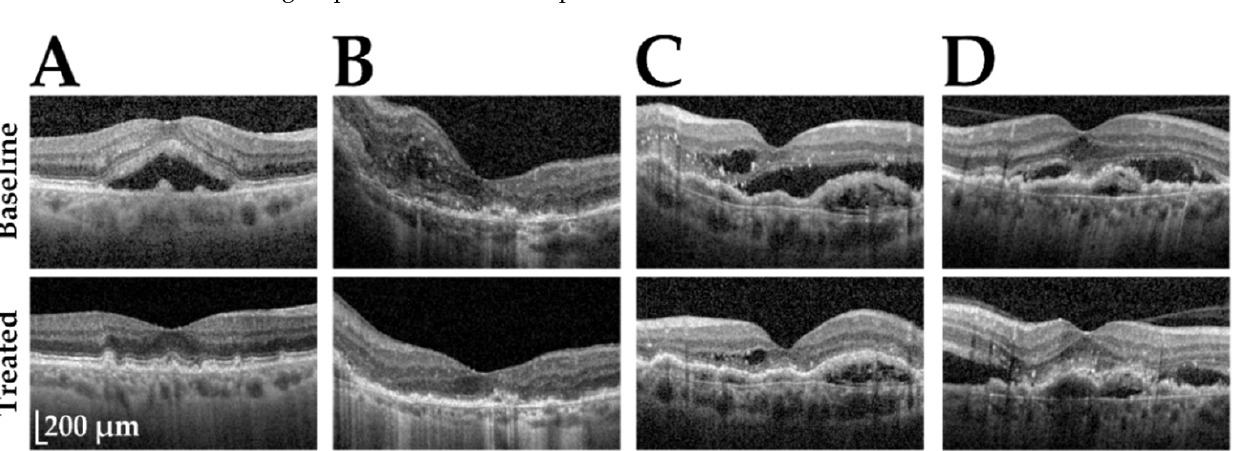
Figure 1. Exemplary optical coherence tomography (OCT) images of nAMD patients and their cat- egorization according to treatment responses. Shown are the OCT images of four patients ( A – D ) before (baseline) and after treatment (treated). Individuals in ( A ) and ( B ) were assigned to the re- sponder group, while probands in ( C ) and ( D ) were more complex in their response to treatment. The individual in ( C ) was categorized as a responder due to morphological improvements (101 µm decrease in central retinal thickness) and a strong improvement of visual acuity (gain of 0.3 log- MAR), although a dry retina was not achieved during the treatment period. The patient in ( D ) was not responsive to the treatment and was assigned as a non-responder.